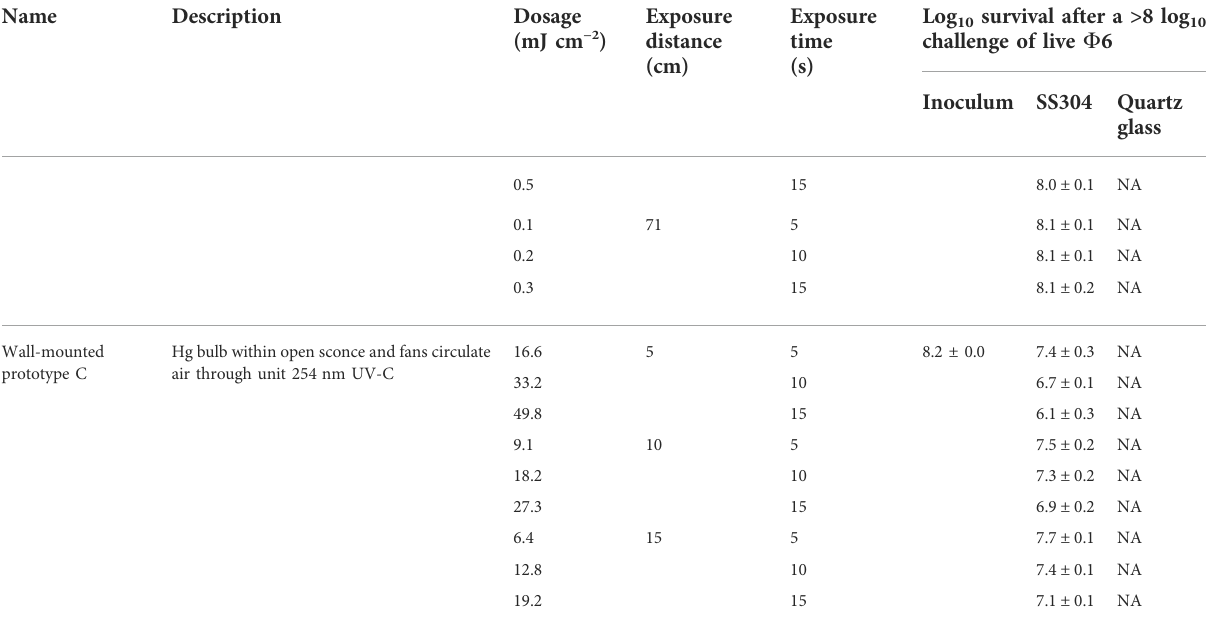
TABLE 5 ( Continued ) Dosage and ef fi cacy of room air-irradiating prototypes showing log 10 survival data based on the average power from the bulb area,notthepeaks.White(lowdecontamination)=Fail < 2log 10 ;yellow(sanitation)=Fail ≥ 2log 10 , < 3log 10 ;lightblue(disinfection)=Pass ≥ 3log 10